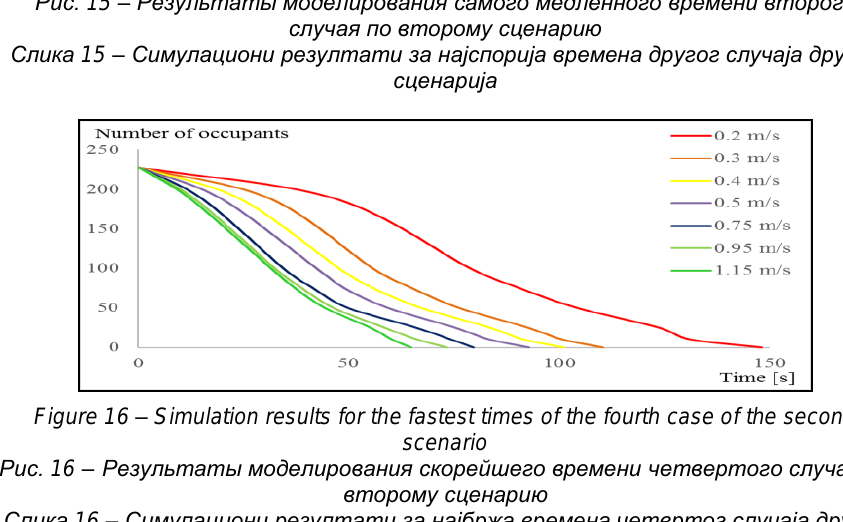
Figure 15 – Simulation results for the slowest times of the third case of the second scenario